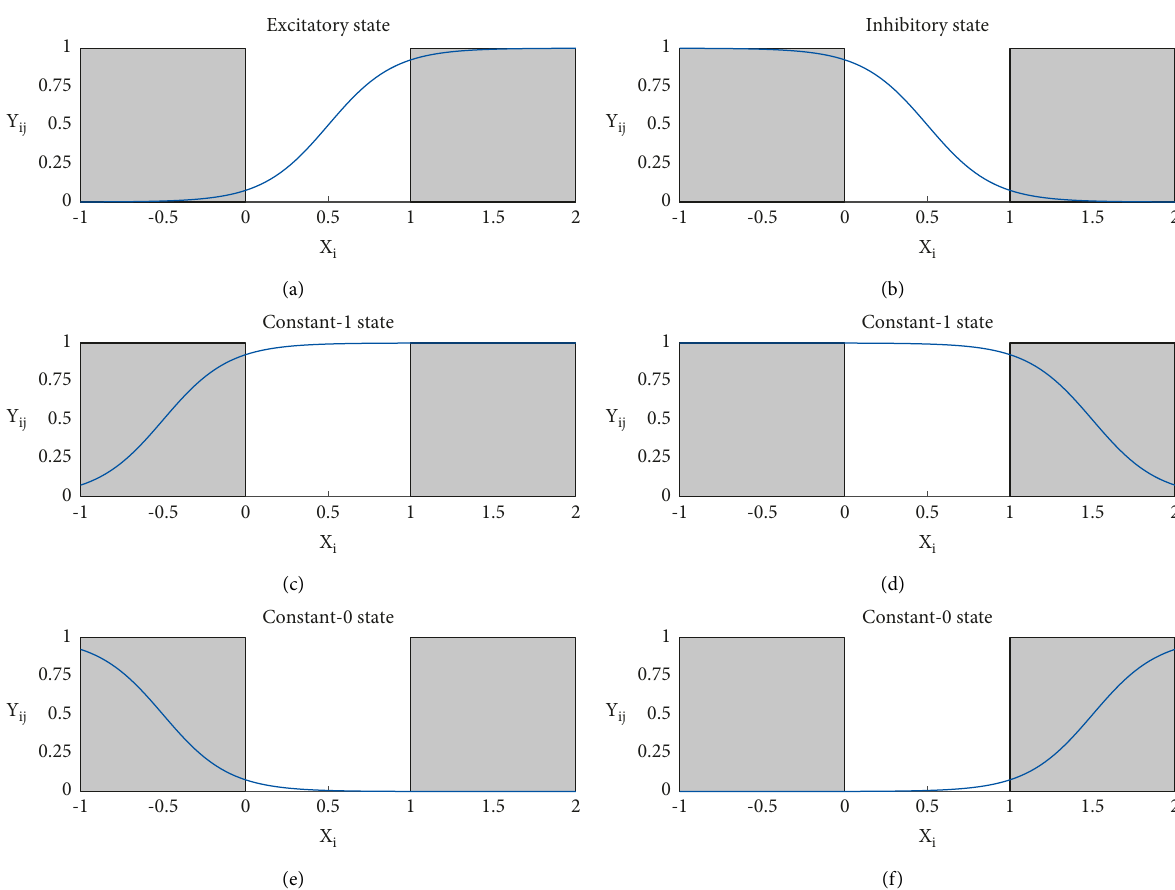
Figure 2: Four different connections in the synaptic layer: (a) excitatory connection, (b) inhibitory connection, (c) constant 1 connection, (d) constant 1 connection, (e) constant 0 connection, and (f) constant 0